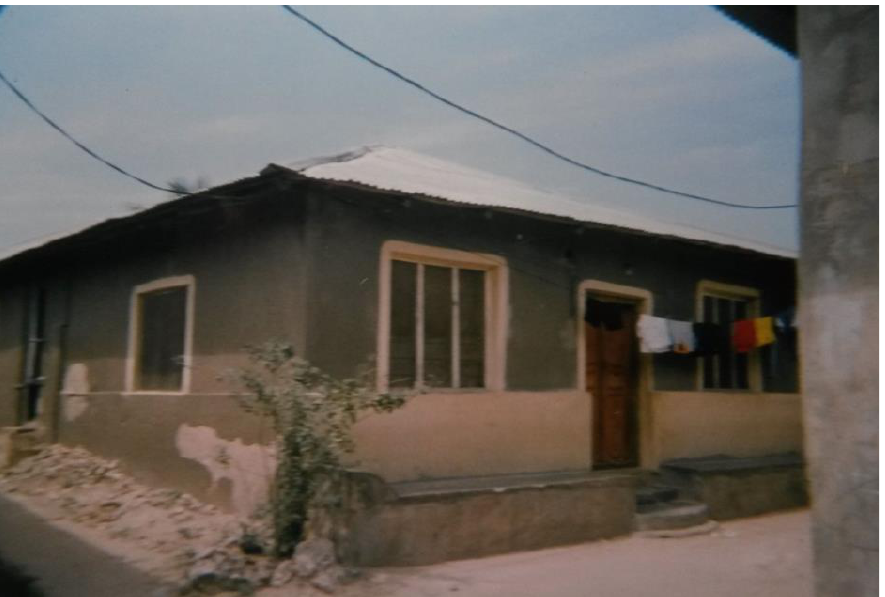
Figure 6. ‘A child is supposed to be given safety [ apewe usalama ] and not to be left roaming around [ kuachiwa kurandaranda ] because nowadays children are being stolen [ wanaibiwa ] ’ . (Yusra 13 years